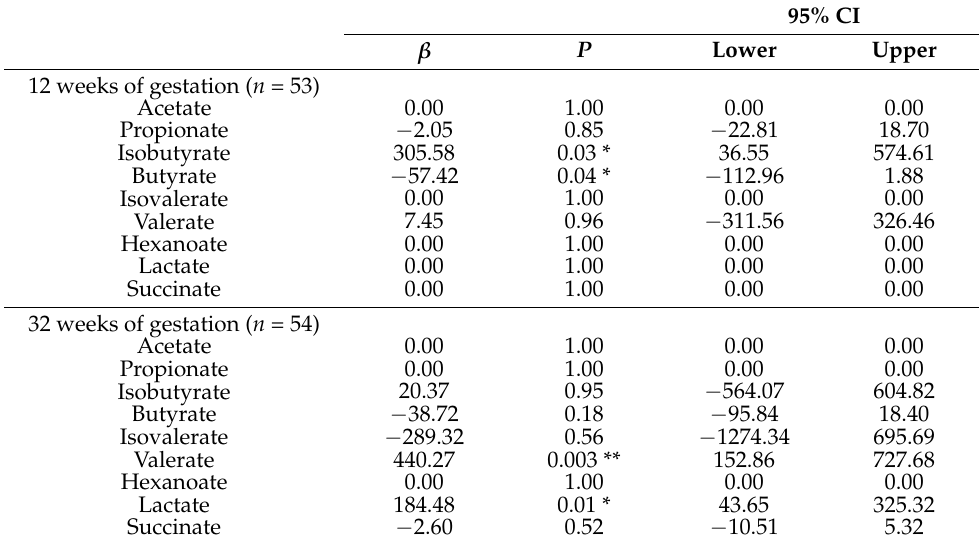
Table 2. Associations between CB CCL17 and short-chain fatty acid levels in maternal feces 1